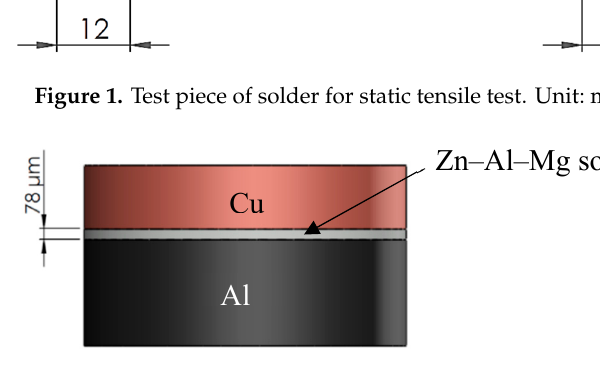
Figure 2. The fit-up of soldered joints.